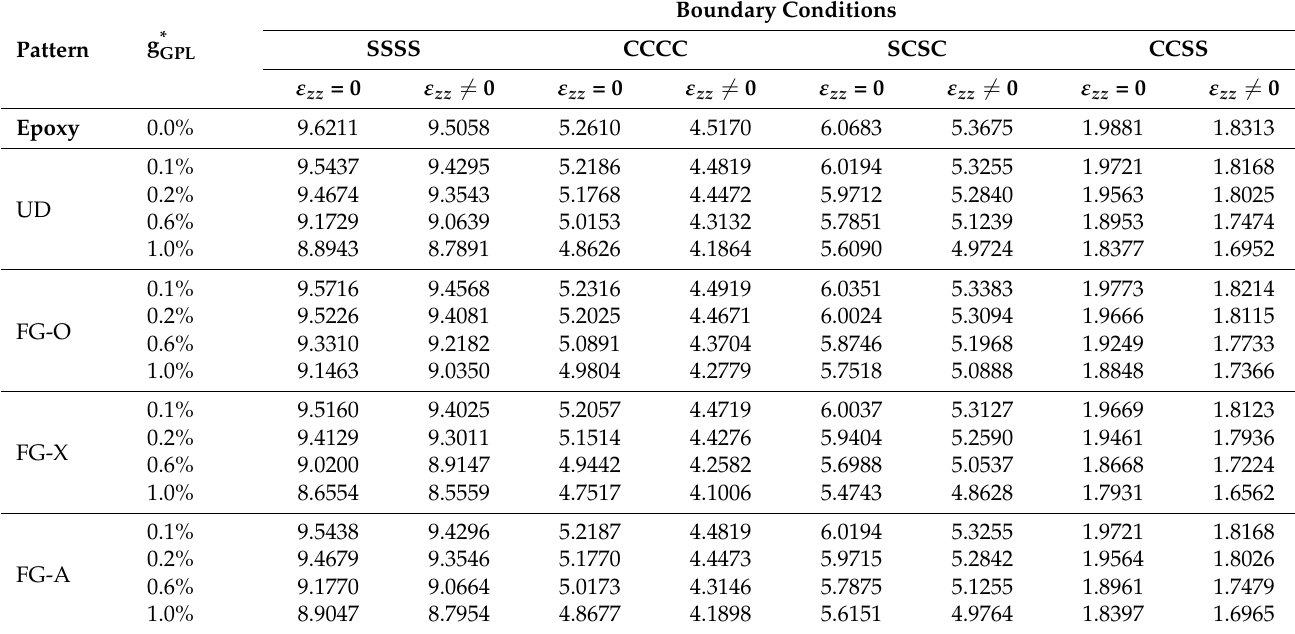
Table 10. Dimensionless displacements of GRC plate under various boundary conditions influenced by weight fraction g ∗ GPL